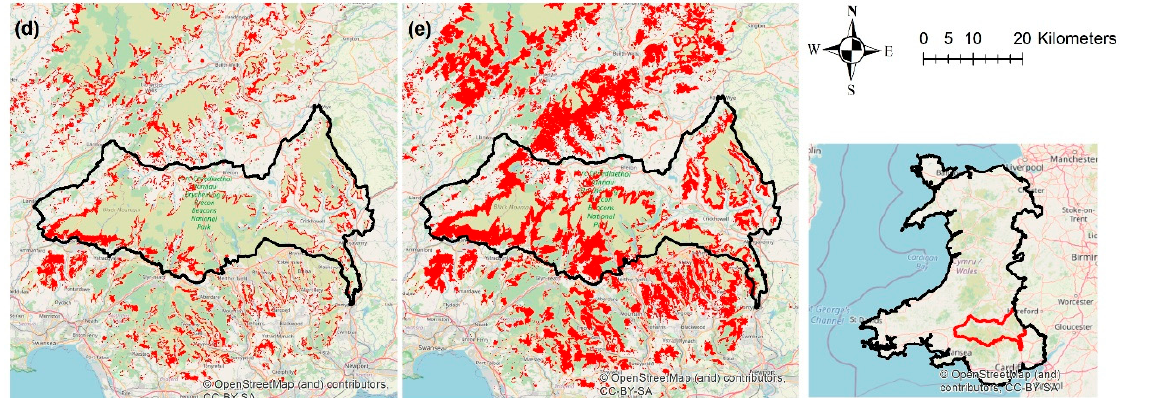
Figure 4. Projected expansion of Broadleaf Forest in and around the Brecon Beacons National Park, Wales by 2030, indicated by red overlay. Individual projections represent the ( a ) Business as Usual (B-a-U), ( b ) Green Future (GF), ( c ) Free Trade Agreement (FTA), ( d ) World Trade Organisation (WTO) and ( e ) Unilateral Trade Liberalisation (UTL) scenarios.